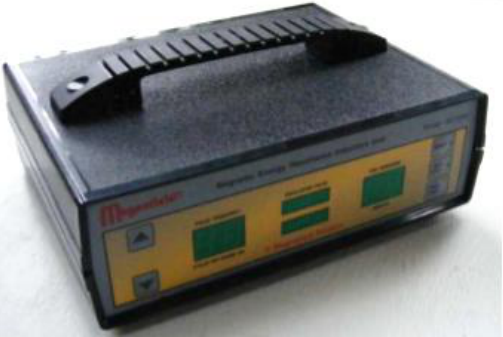
Figure 2. Magnafield® for generating bio-inspired electromagnetic signals.